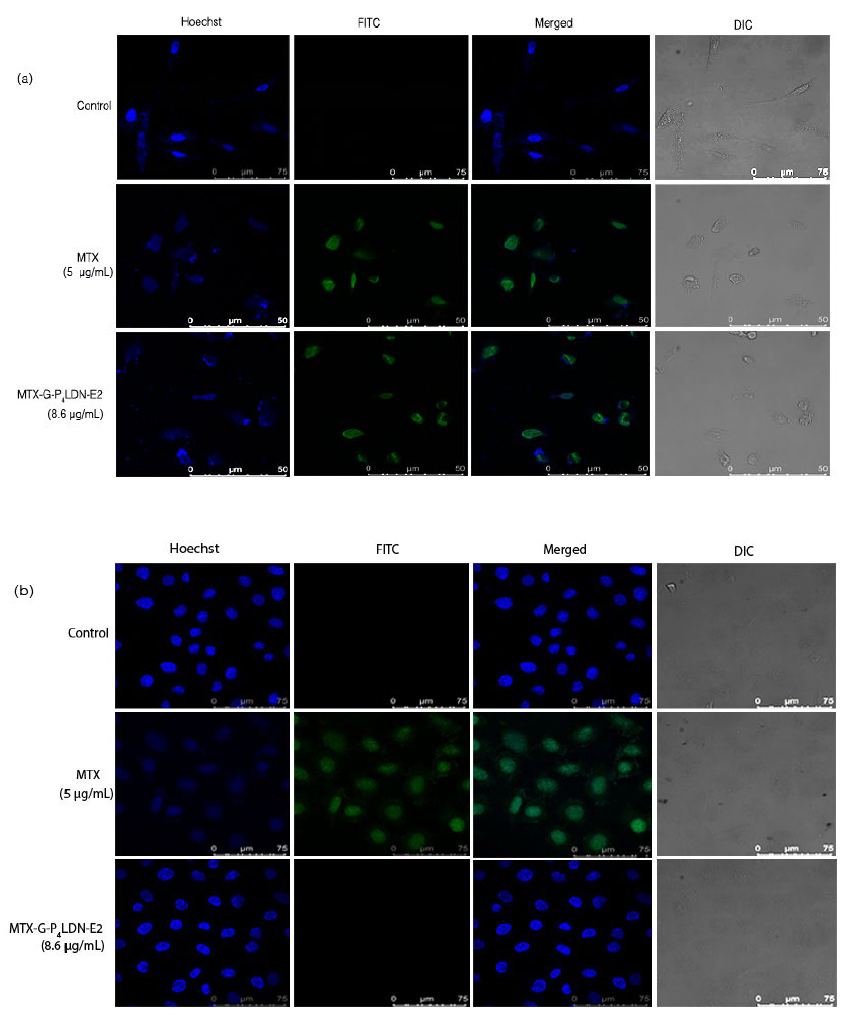
Figure 5. Confocal microscopy images of ( a ) MDA-MB-231 (EGFR overexpressed) and ( b ) SiHa (EGFR negative) cells after 24 h incubation with MTX and MTX–G–P 4 LDN–E2.